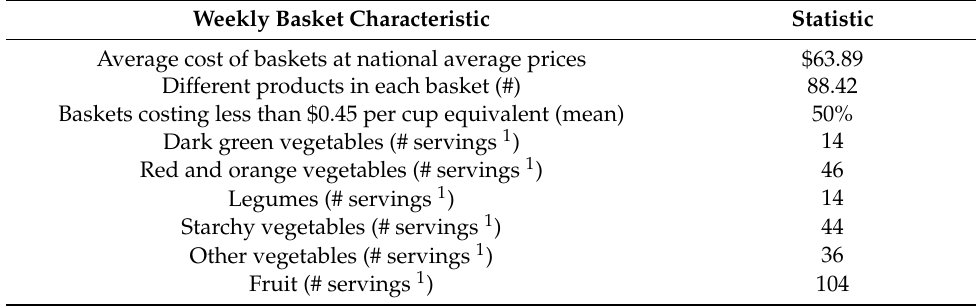
Table 3. Characteristics of 1000 simulated baskets that satisfy Federal dietary recommendations for fruits and vegetables for a 4-person family over 1 week. Weekly Basket